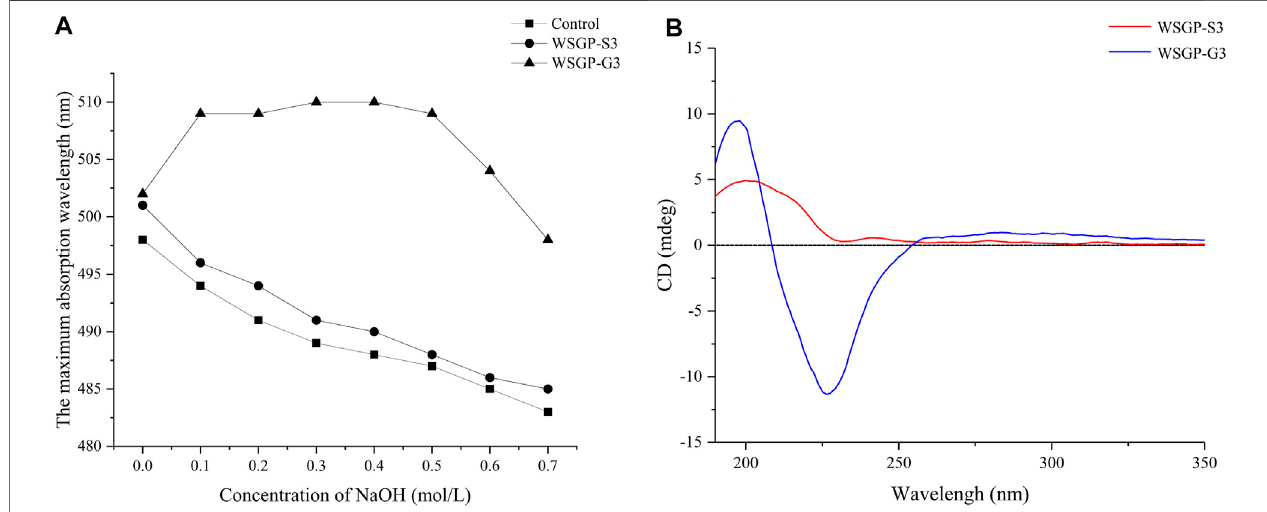
FIGURE 2 | Characteristics of WRPG-G3 and WRPG-S3: (A) Changes in absorption maximum of Congo red-WRGP-G3 and red-WRGP-S3 complex at various concentrations of NaOH; (B) CD spectra of WRPG-S3 and WRPG-G3.